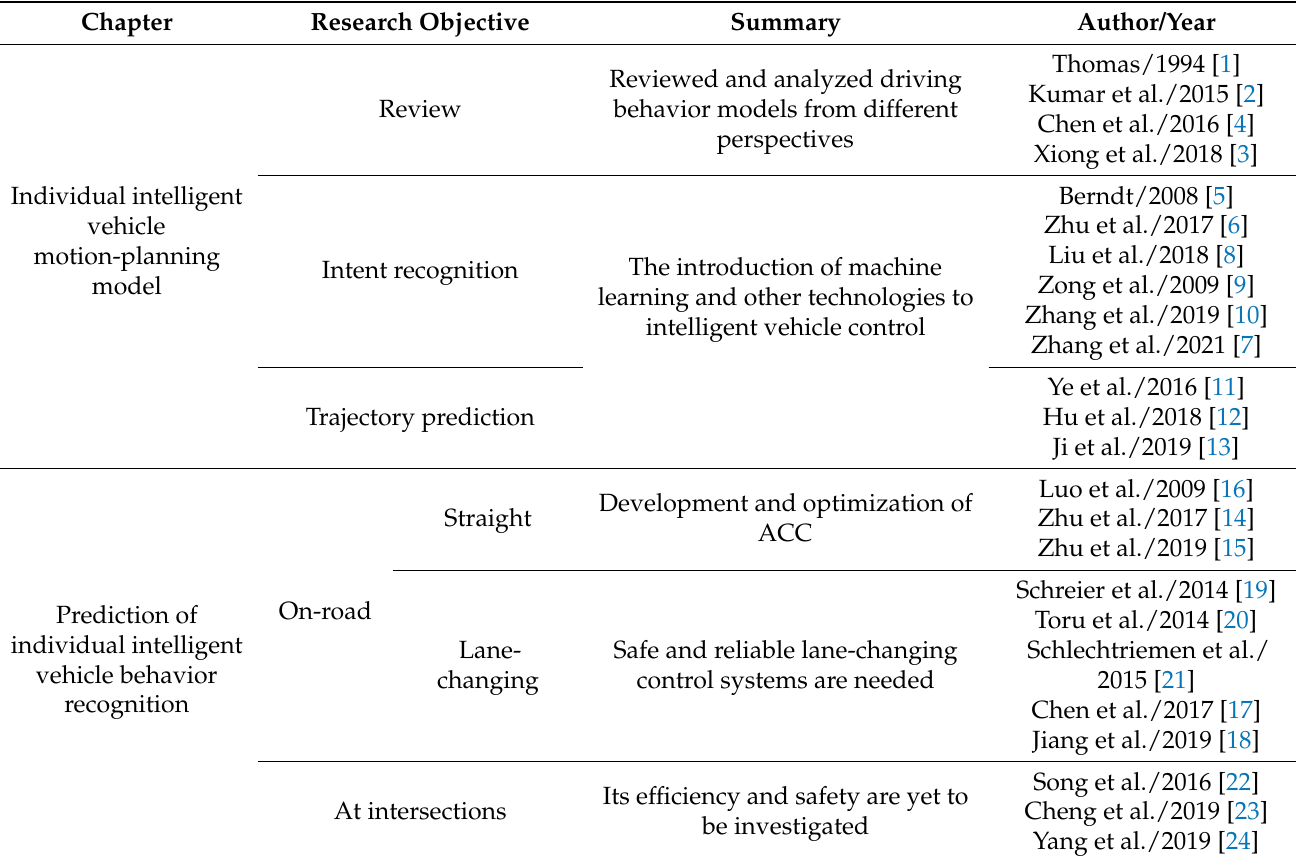
Table 3. Research summary of individual intelligent vehicle driving behavior